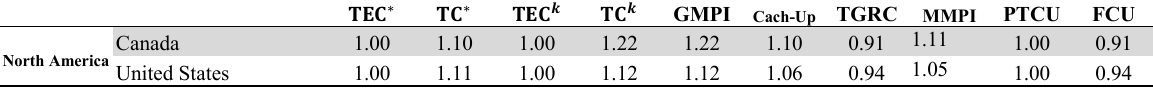
Calculations of productivity changes using the metafrontier Malmquist method for North